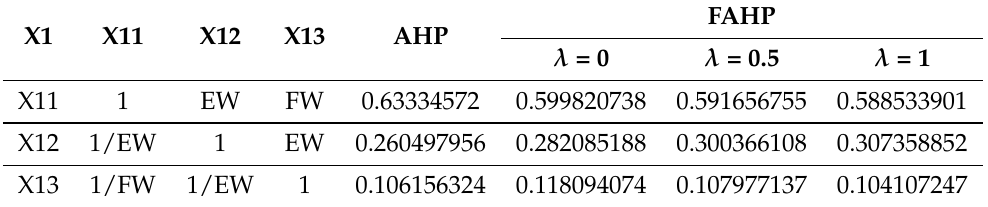
Table 4. Fuzzy comparison matrix for the sub-criteria X1. ( CI = 0.01935734, CR = 0.033374725).